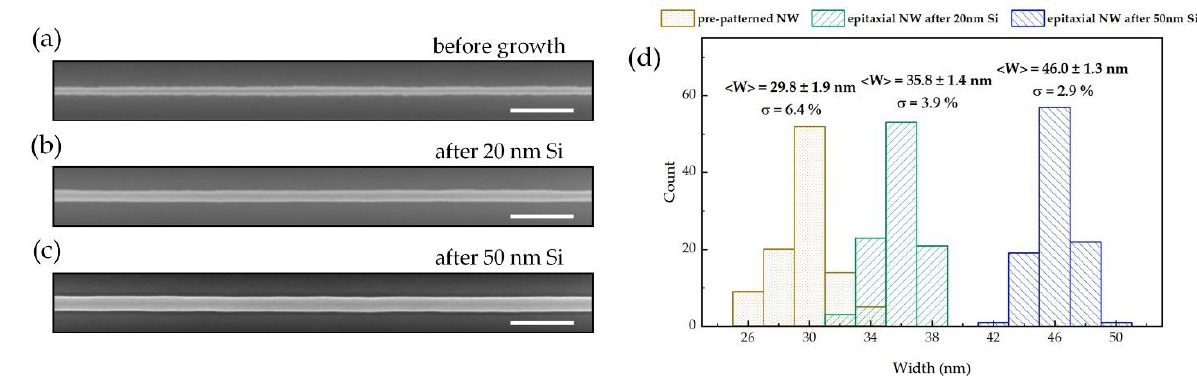
Figure 6. ( a–c ) SEM images of a 30 nm wide pre-patterned trapezoidal NW, epitaxial NWs after the deposition of 20 nm Si and 50 nm Si, respectively. Scale bar: 200 nm. ( d ) Statistical histogram showing the width distribution of 30 nm wide pre-patterned NWs, epitaxial NWs after the deposition of 20 nm and 50 nm Si layer. The average width <W> and relative standard deviation σ of the NWs are quoted.